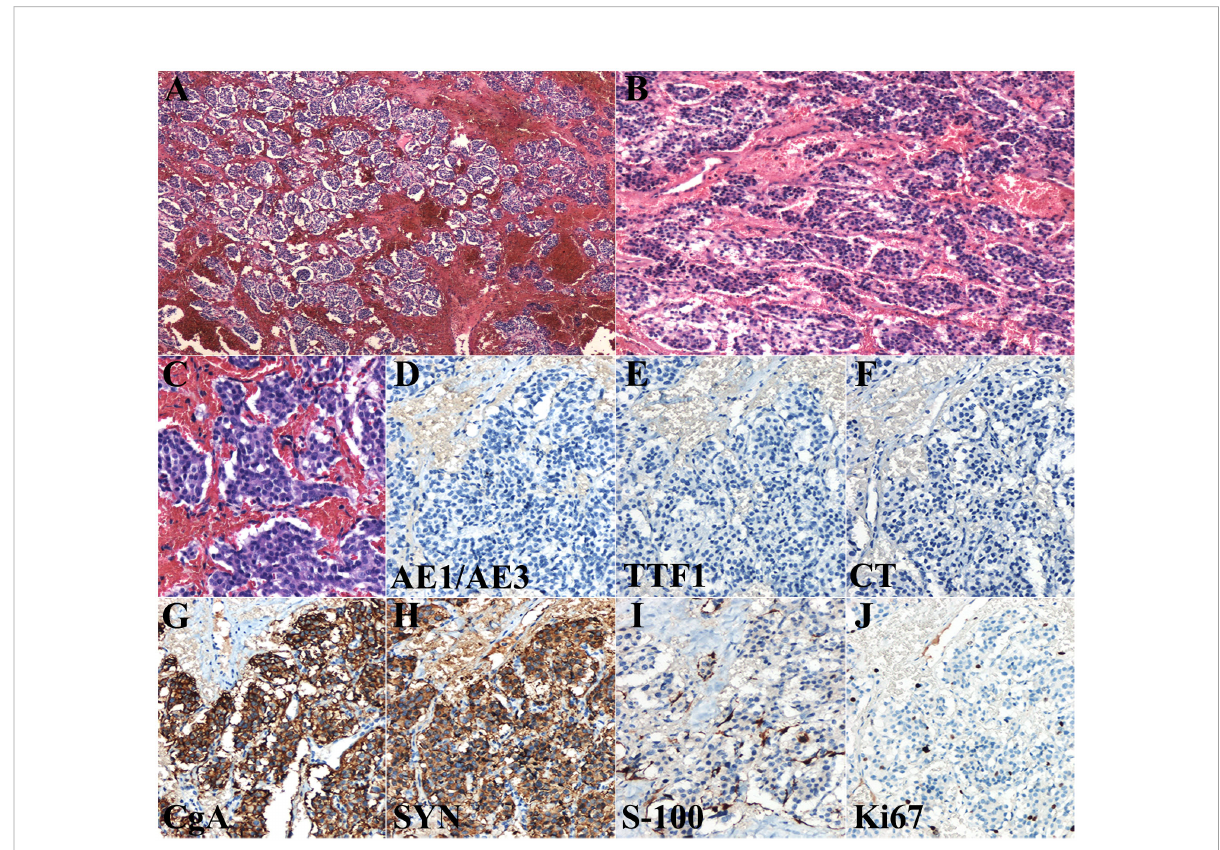
FIGURE 3 Histological features of the postoperative paraf fi n section (A – C) and immunohistochemical examination (D – J) of thyroid paraganglioma. Scale bars: 400 m m (A) , 300 m m (B) , and 100 m m (C – J) . CgA, chromogranin A; CT, calcitonin; Syn,